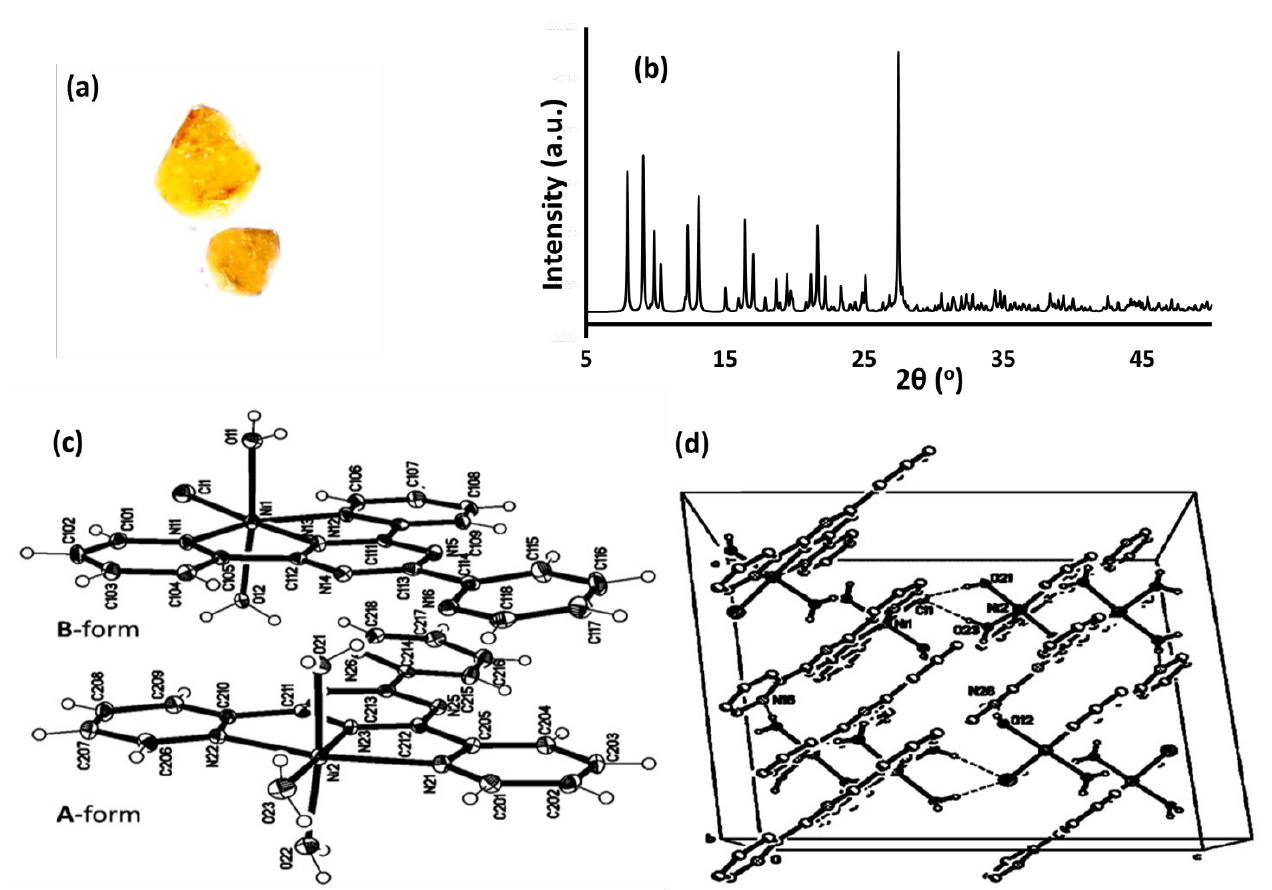
Figure 2. ( a ) Normal crystals image, ( b ) single crystal XRD pattern, ( c ) ORTEP and ( d ) packing diagrams of {[Ni(tptz)